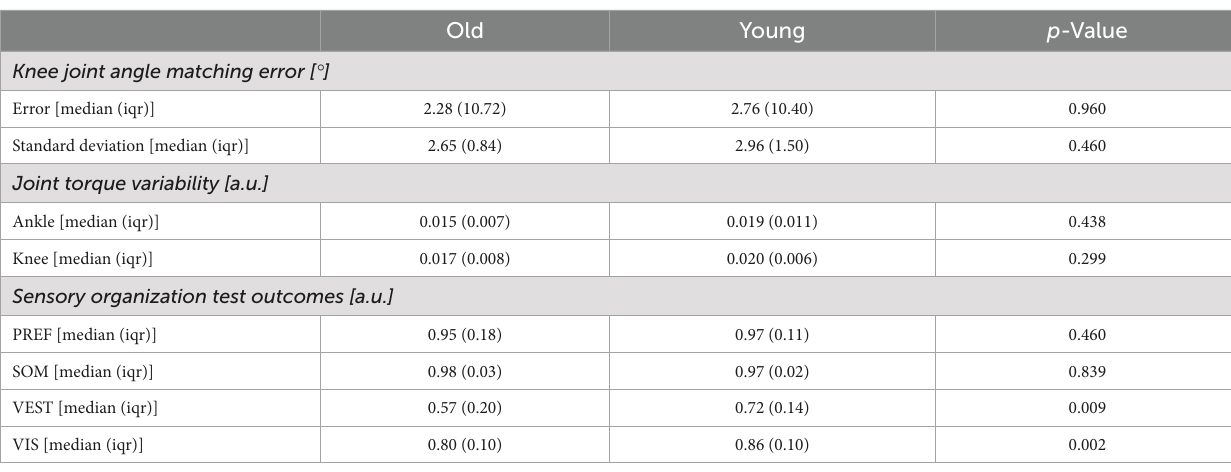
TABLE 2 Between group differences in sensorimotor outcomes.